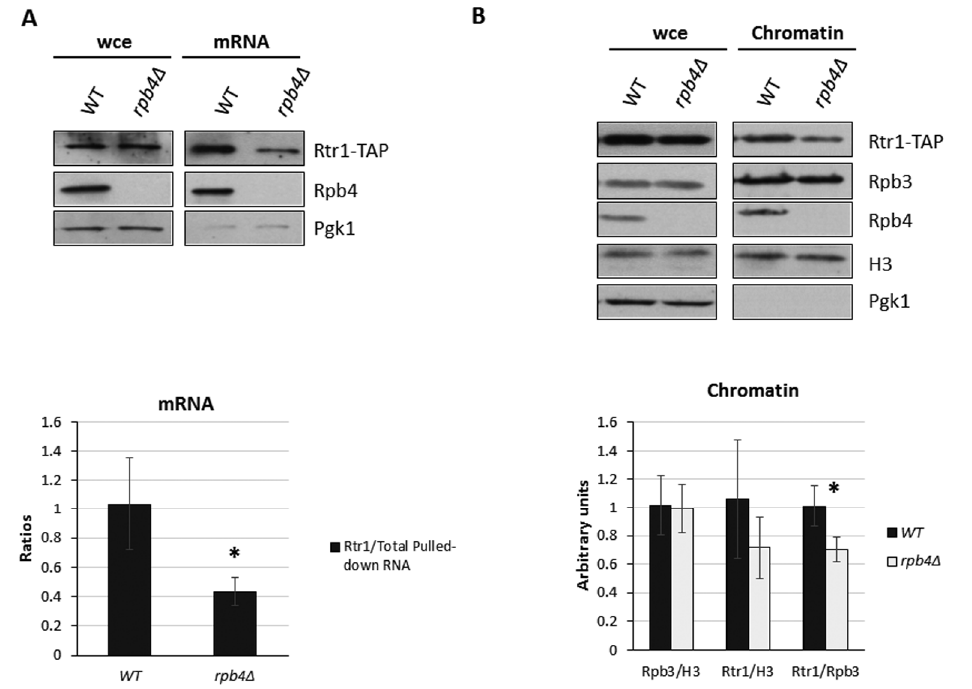
Figure 7. Rtr1 and Rpb4 cooperate to control mRNA stability. ( A ) Western blot of whole-cell crude extracts and oligo-dT purified mRNAs after exposure to 1200 mJ/cm 2 of 254 nm UV in wild-type and rpb4 ∆ mutant grown in SD medium at 30 ◦ C. Pgk1 was used as a negative control of mRNA- associated proteins. ( B ) Western blot of whole-cell extracts and chromatin-enriched fractions obtained by yChEFs procedure [63,64] from rpb4 ∆ mutant and its isogenic wild-type strain grown in YPD medium at 30 ◦ C. A similar amount of chromatin was purified from wild-type and mutant strains as similar levels of histone H3 were detected. Pgk1 was used as a negative control of cytoplasmic contamination. Rpb4 was detected by a specific anti-Rpb4 antibody and Rtr1 was detected using an anti-TAP antibody in strains containing an rtr1::TAP allele. All experiments corresponded to at least three independent biological replicates. * p < 0.05 ( t